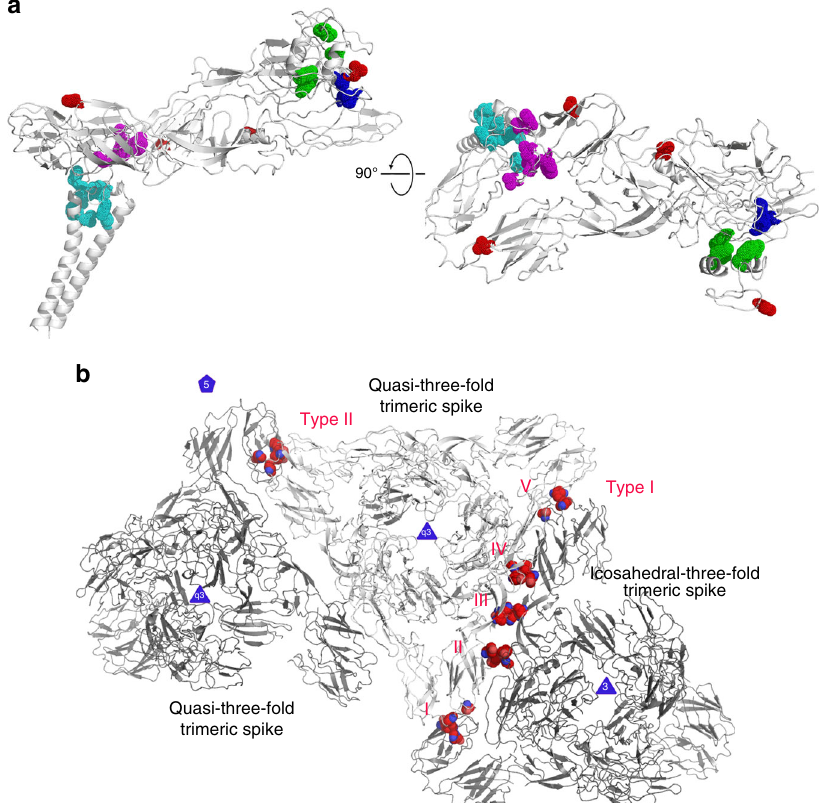
Fig. 4 Amino acids (displayed as dot in Pymol) that involved in the key interactions which identi fi ed or discussed in this SINV structure. a The completely or highly conserved amino acids of E1 and E2 that are involved in the interactions of forming the hydrophobic pocket and forming the hydrophobic contact with pocket factor are colored in cyan. The amino acids of E1 that are involved in connecting the stem loop with E1 DIII and E2 domain C are colored in magenta. The completely conserved amino acids of E3 and E2 that are involved in hydrophobic interaction between E3 and β -ribbon connector are colored in green. The completely or highly conserved amino acids of E1 S57, E2 H164 and H211 that form an interaction at neutral pH but become repulsive at low pH to facilitate the dissociation of β -ribbon connector from E1 are colored in blue. The identi fi ed glycosylation sites are colored in red. b Amino acids of E1 that are involved in the type I and II inter-triangle interactions are colored in